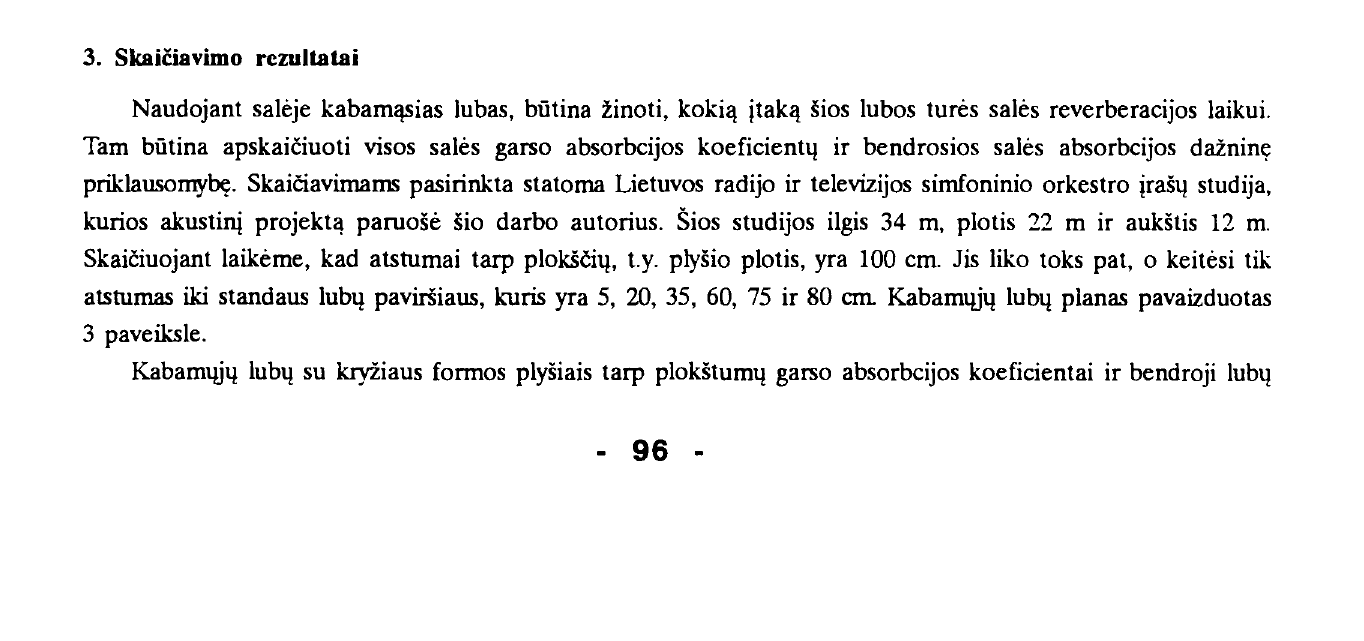
fomms. Nuo jos taip pat pri.ldauso ir pataisa 2/ll . Jeigu garso banga i plokStuiru! krenta ne normaliniu kampu, o kampu 8, tai suradus impedans~t, randamas atspindZio